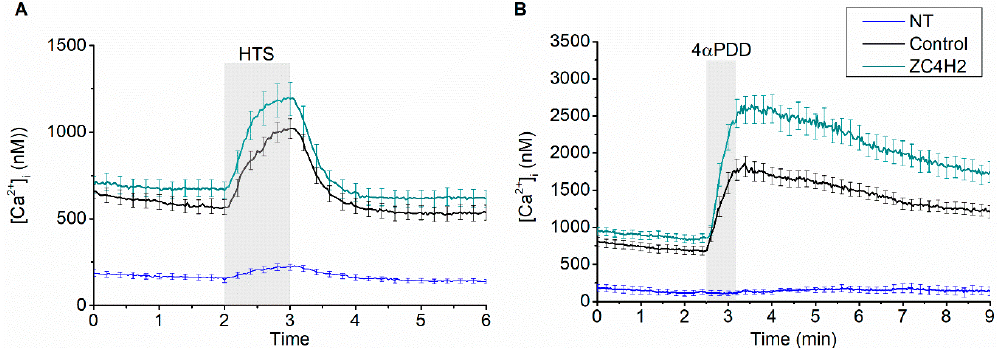
Figure A2. Expression levels of TRPV4 and ZC4H2 in HEK-293T cells. mRNA expression of TRPV4 and ZC4H2 in non-transfected (NT) cells and cells co-transfected with TRPV4-GFP and ZC4H2-mCherry.